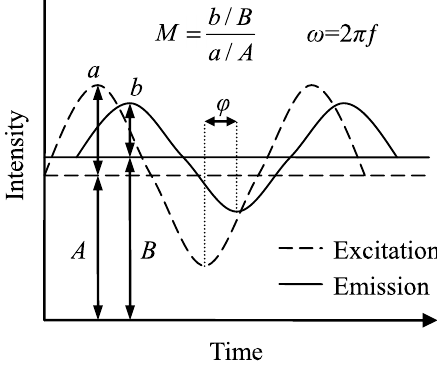
Fig. 3. Frequency domain FLIM method.